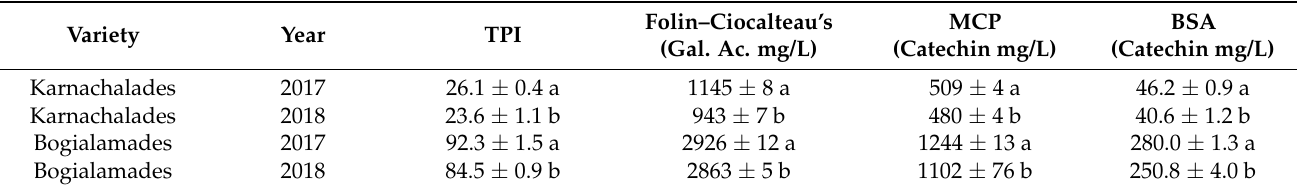
Table 5. Results from One–Way Analysis of Variance (ANOVA) with Tukey’s test, of phenolic characteristics of “Karnacha- lades” and “Bogialamades” wines in two consecutive vintages.